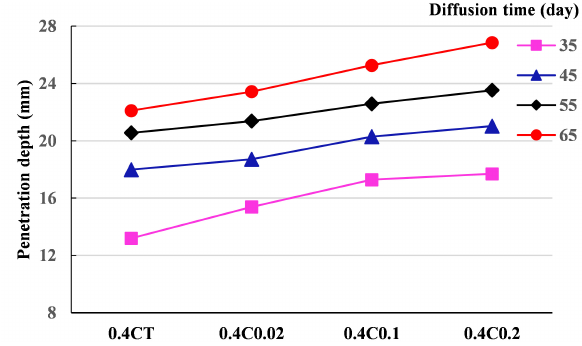
Figure 7: Penetration depth of mortar by natural chloride diffusion tests